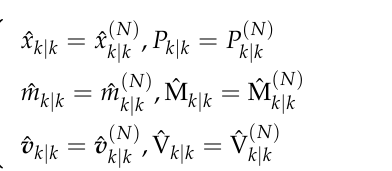
Equation (47) gives the result of the end of the iterative process.